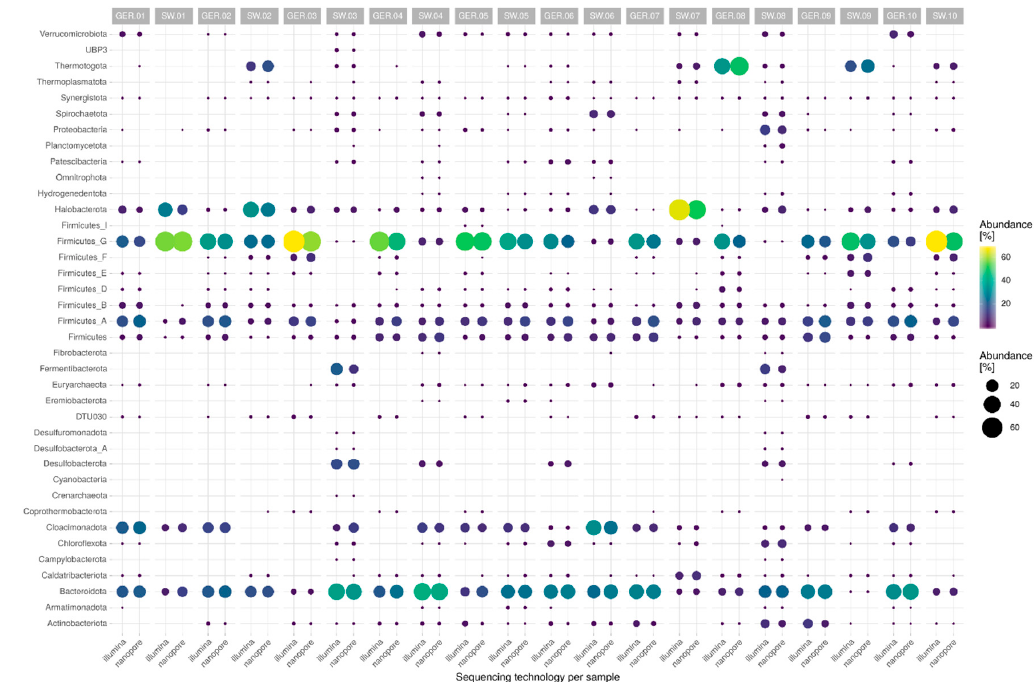
Figure 4. Summary of abundance for samples from all 20 reactors, calculated on the basis of all classified reads for nanopore and Illumina sequencing. Only phyla with at least 0.1% abundance are shown (circles). The size and colour of each circle correspond to the abundance of each phylum in each reactor. Taxonomic names are based on GTDB version r89 (https://gtdb.ecogenomic.org), which includes “placeholder” names such as Firmicutes_A. DTU030 corresponds to the National Center for Biotechnology Information (NCBI) phylum Firmicutes. UBP3 corresponds to “bacteria” classification via NCBI. The reactor samples are described in detail in Table 1.